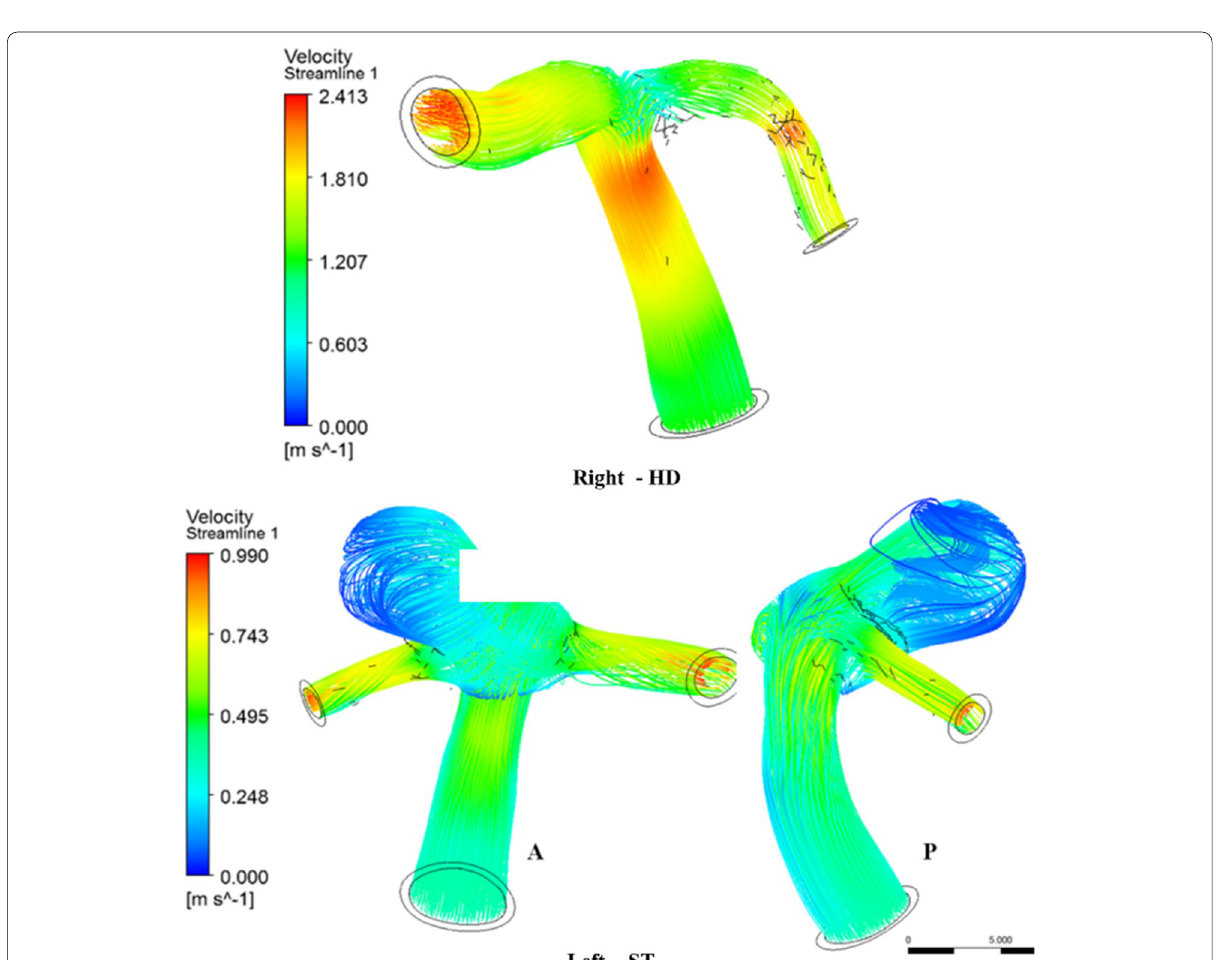
Fig. 6 Comparison of velocity streamlines during peak